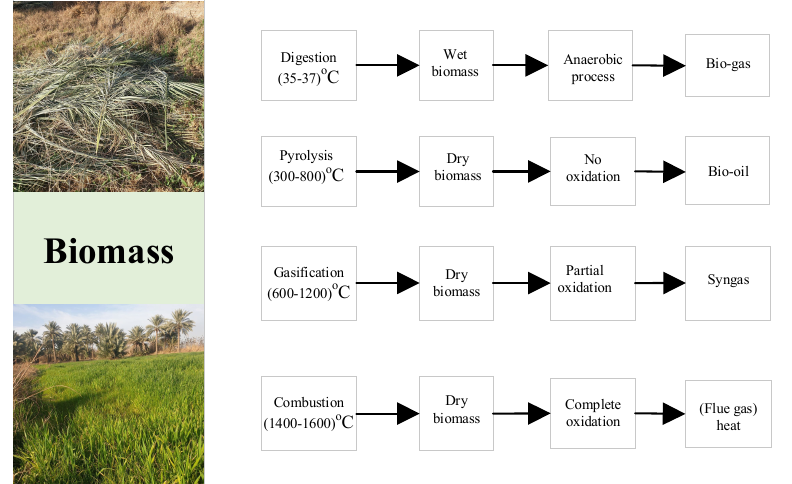
Figure 8. Technologies for biomass conversion.